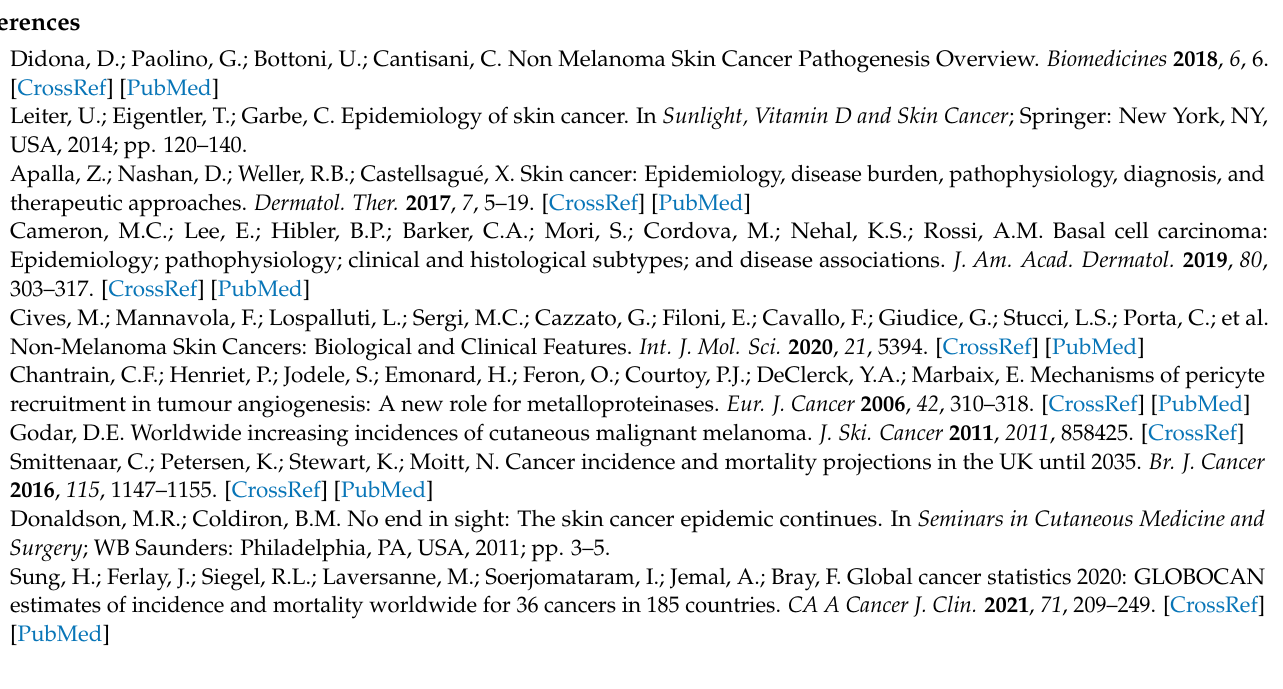
Figure S2. Convergence of loss functions for training set and validation set of original images and precision, recall, and average precision. Figure S3. Hyperspectral image training set and valida- tion set loss functions and convergence of precision, recall, and mean precision. Table S1. Heatmap of the confusion